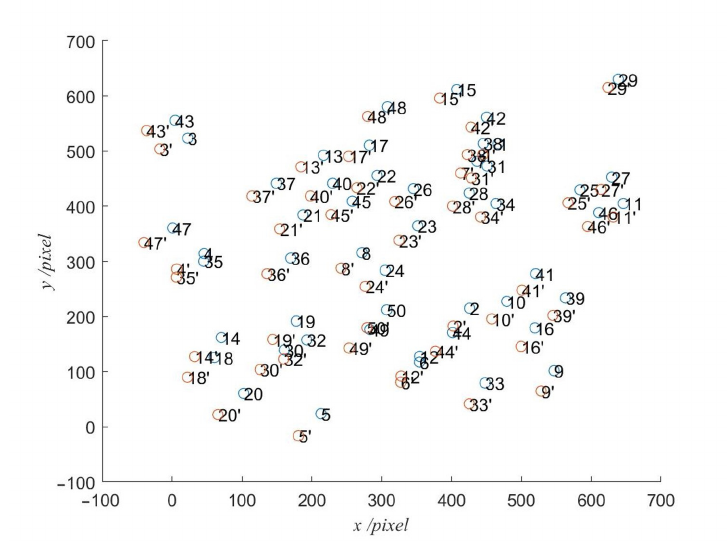
Figure 3. The simulation of points in the 1500 × 1500